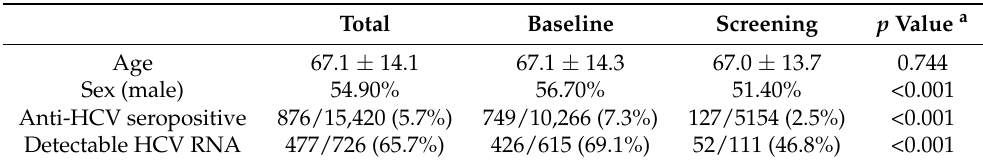
Table 1. The basic characteristics, anti-HCV seropositivity rate and percentage of patients with detectable HCV RNA among the baseline, screening, and total population groups. The baseline group was defined as patients who had laboratory tests before screening, and the screening group was defined as patients who completed tests during the screening period.